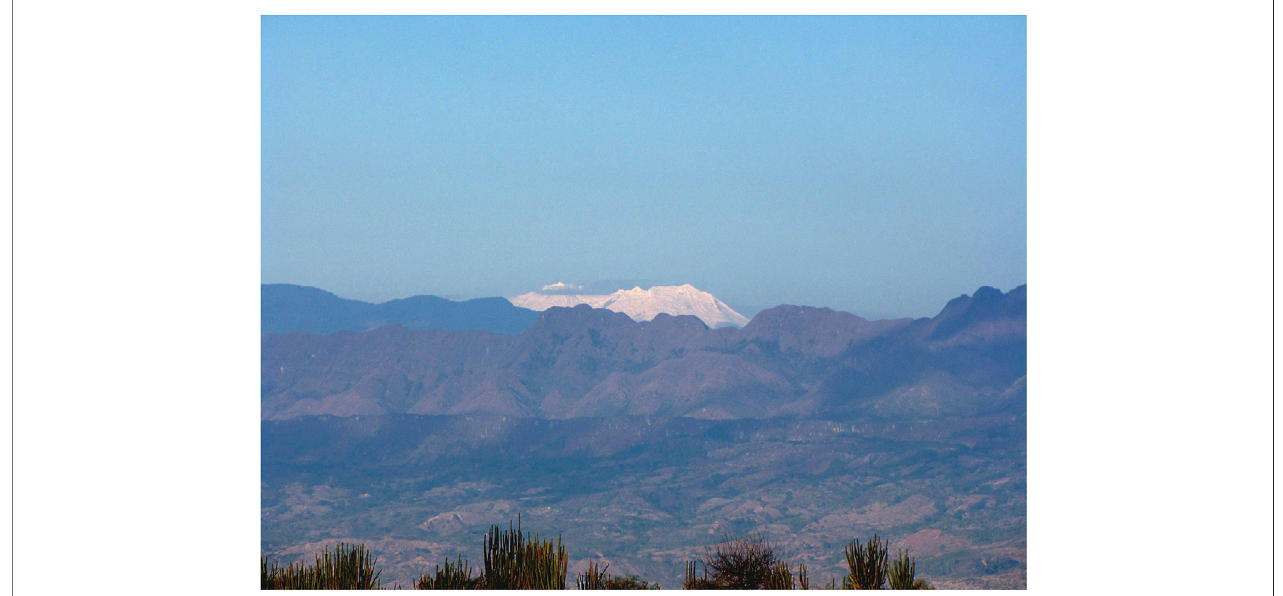
FIGURE 10 | Huila Volcano, a massive ∼ 5,600 m a.s.l. active composite volcano as seen from the Tatacoa Desert, looking west (see Figure 1 for location). Eastward migration of a Miocene magmatic arc built these volcanic edi fi ces ( Figure 1 ) starting at ∼ 4 Ma (Barberi et al., 1988; Ujueta, 1999; Torres-Hernandez, 2010), that along with contractional deformation along the fl anks of the Central and Eastern cordilleras (Alfonso et al., 1994; Saeid et al., 2017), severed any fl uvial communicationbetweentheCaucaandMagdalenavalleys.RidgesintheforegroundcorrespondtoOligocenemolassedepositsinvolvedintheeast-vergent,fold- and-thrust belt at the toe of the Central